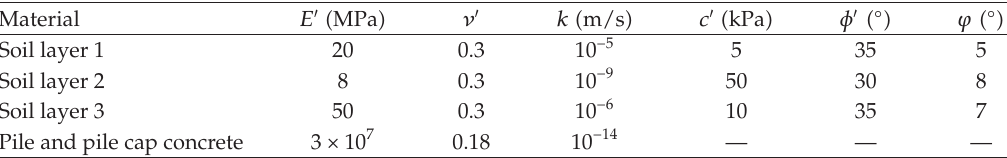
Table 3: Material properties for the pile-group